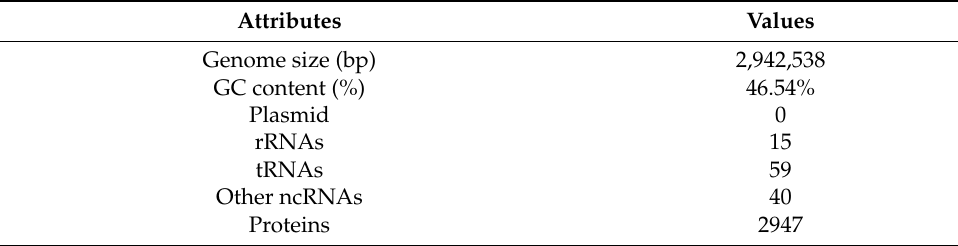
Table 3. Analysis of CAZy in L. paracasei TK1501.